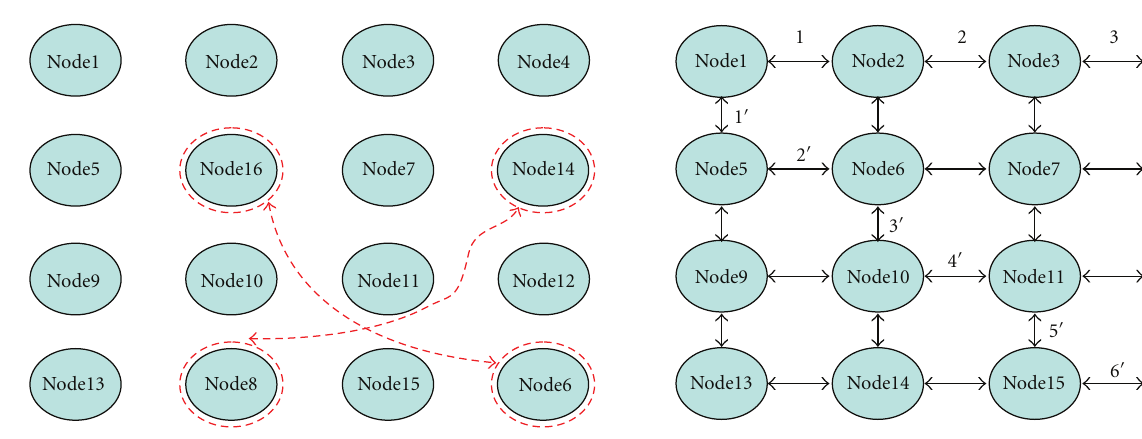
Figure 15: Topology A of 6-hop network.